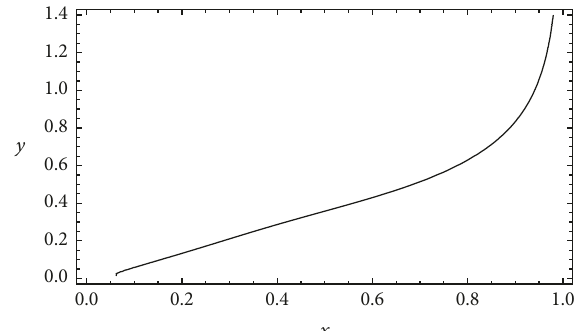
Figure 3: The 𝑦 - 𝑥 curve for (25) with 𝑄 𝑐 = 𝑙/6 , 𝑞 𝑐 = √5−2 , 𝑙 = √3 .